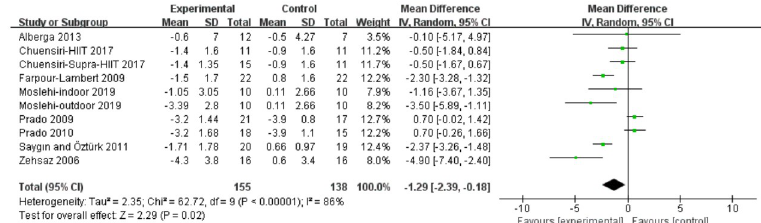
Fig 4. Forest plot of comparison: Body fat percentage